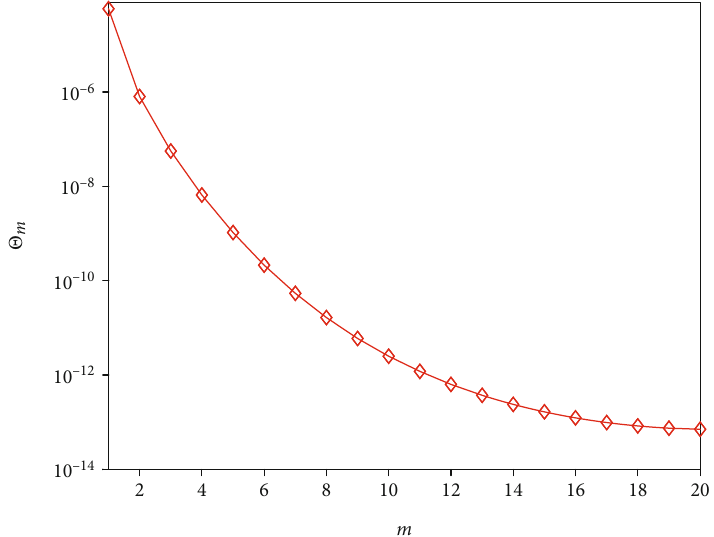
Figure 28: Variation of the LSPM numerical solution G = 0 : 6, Ω = 0 : 1, andHe = 0 : 2 : 0 : 5, Pr = 10, S = 3, N R